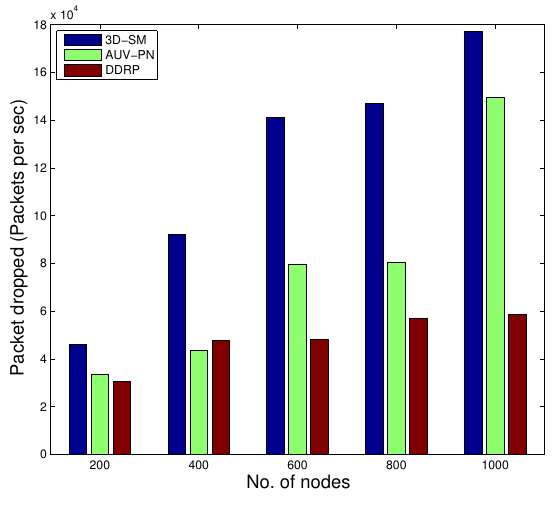
Figure 18. Packet drop